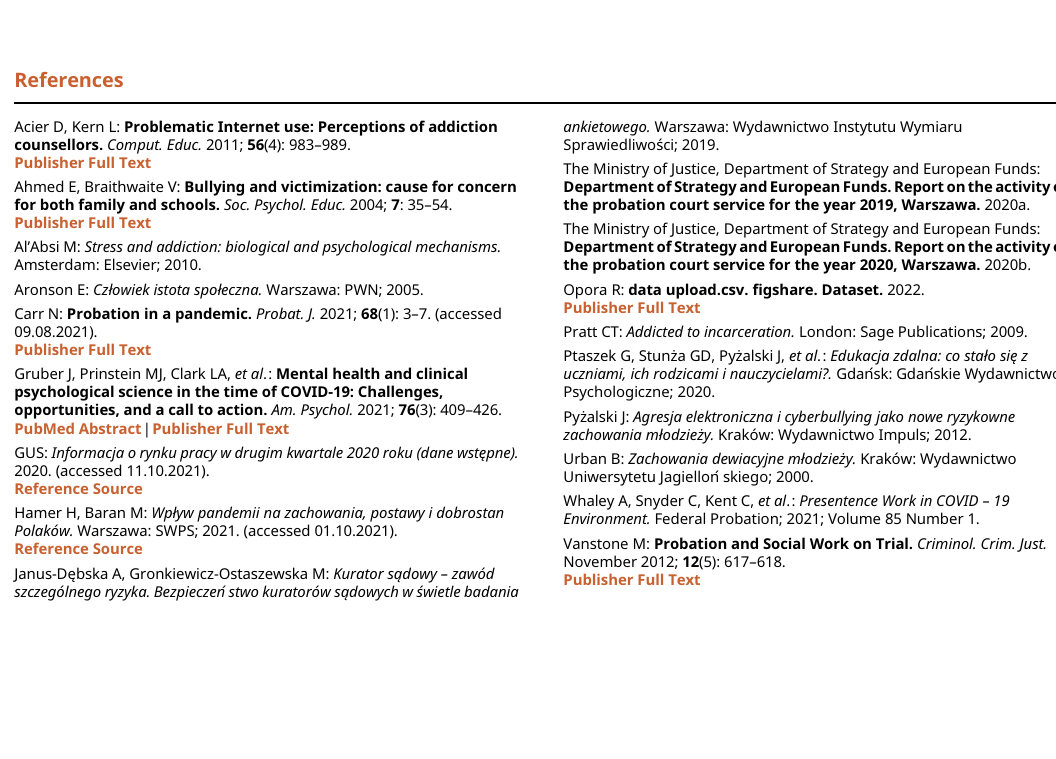
Figshare: data upload.csv. https://doi.org/10.6084/m9.figshare.19447193.v3 (Opora,